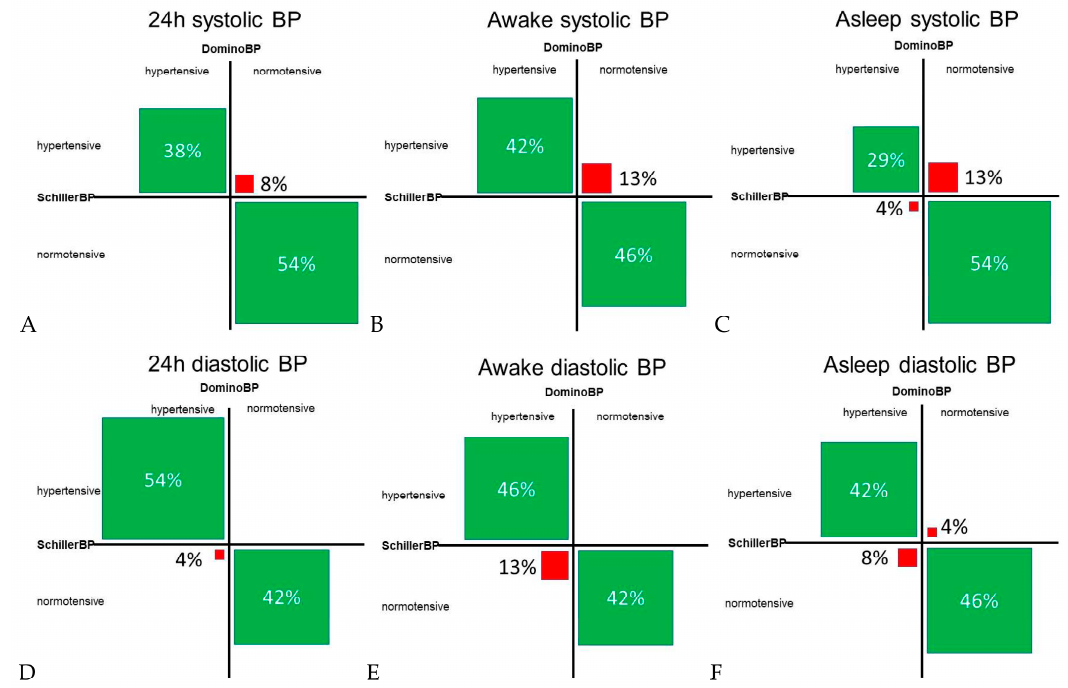
Figure 5. Concordant and discordant blood pressure classification in cases with a systolic and diastolic blood pressure difference of > 5 mmHg between blood pressure data generated by DominoBP and SchillerBP software. Normotensive values for systolic BP: ( A ) BP < 130 mmHg, ( B ) BP < 135 mmHg, ( C ) BP < 120 mmHg; normotensive values for diastolic BP: ( D ) BP < 80 mmHg, ( E ) BP < 85 mmHg, ( F ) BP < 70 mmHg; hypertensive BP is defined as ≥ the defined normotensive BP values; green fields: BP classification concordance between data generated by DominoBP and SchillerBP, i.e., both generated are classified as hypertensive or normotensive BP; red fields: BP classification discordance between data generated by DominoBP and SchillerBP, i.e., according to DominoBP generated data BP values are classified as hypertensive BP, while according to SchillerBP, thegenerated data BP values are classified as normotensive BP and vice versa); BP: blood pressure.